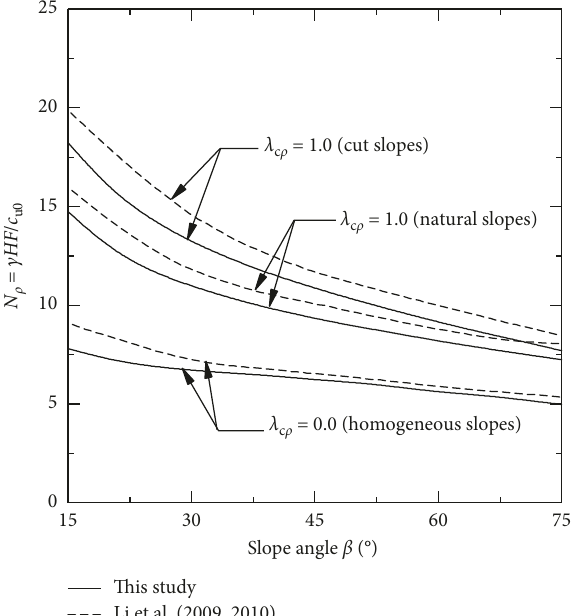
Figure 5: Comparisons between upper bounds to the stability number derived from this study and those presented by Li et al. (2009, 2010) for undrained slopes with B / H � 5.0 and d / H � 2.0.